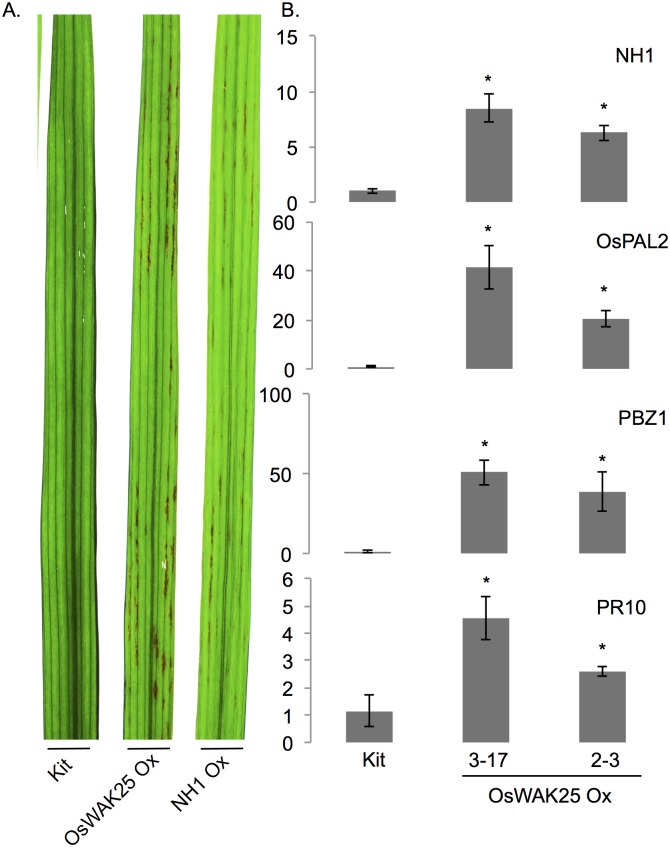
OsWAK25 overexpression plants exhibit mimic lesions and correlate with an upregulation of defense genes.Plants were grown under greenhouse conditions. (A) Leaves collected at six-weeks. OsWAK25 overexpression and NH1 overexpression exhibit similar mimic lesions. Experiment was conducted once with 10 plants for each line. (B) Leaf tissue for RNA extraction was collected from 4-week old progeny from plant lines 3–17 and 2–3 along with Kitaake controls. Y-axes on the graphs indicate fold-change differences from Kitaake. CT values were first normalized to ubiquitin as an internal control followed by normalization to Kitaake. Each bar represents the average and standard error of 3 sibling plants. Asterisks represent statistical significance with Student’s t-test, p < 0.0001. The qPCR assays were conducted twice with similar results.